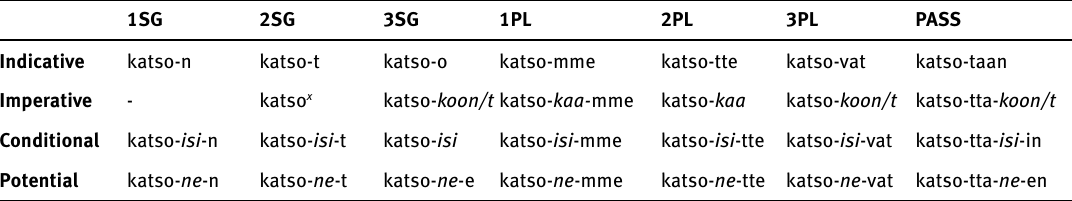
Table 4. Mood inflection in Finnish (simple present of the verb katsoa ‘to look at’)